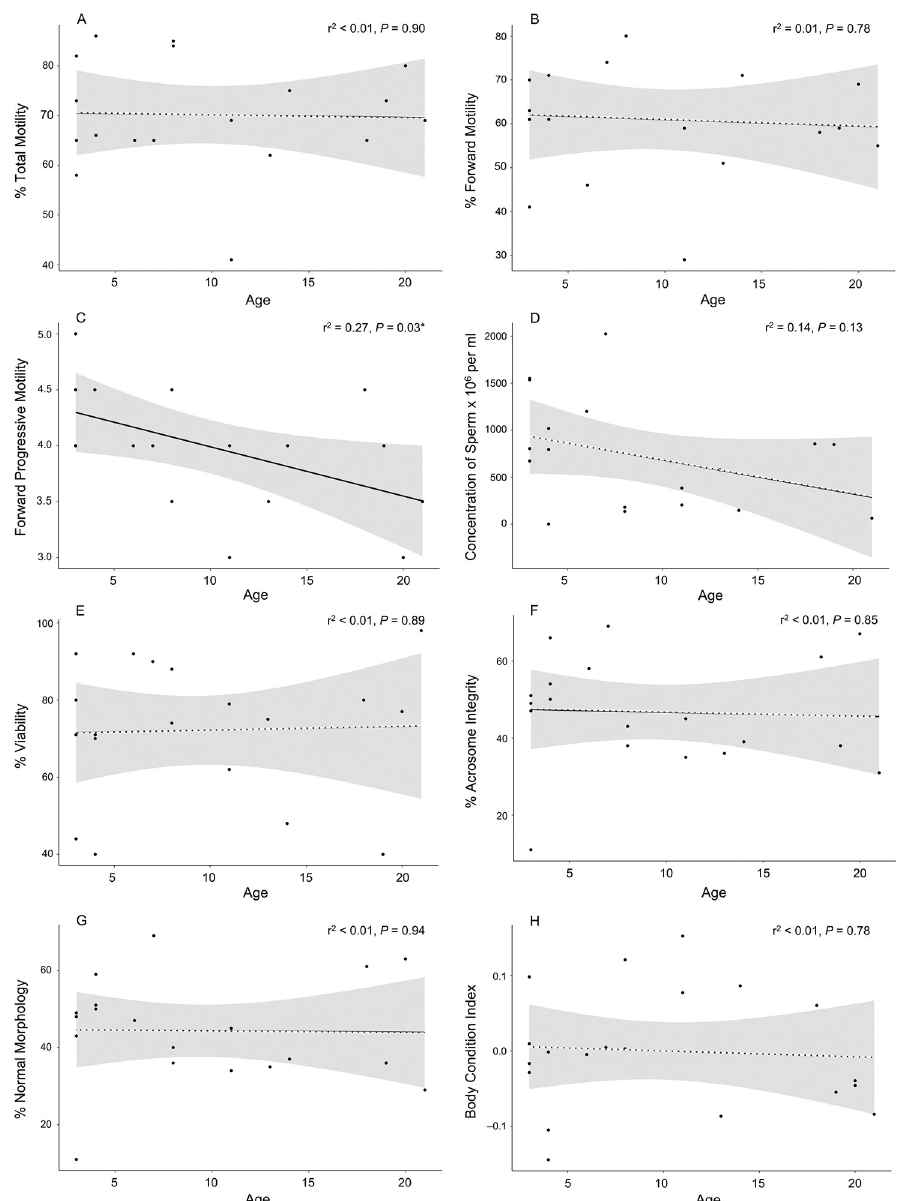
Fig 4. Scatterplots of the linear relationship between A) age and percent total motility, B) age and percent forward motility, C) age and forward progressive motility, D) age and concentration of sperm, E) age and percent viable sperm, F) age and percent normal acrosome, G) age and percent normal morphology of semen, and H) age and body condition of 20 adult male Louisiana pinesnakes. Dashed lines represent a non-significant regression line at the 0.05 level and shading shows the 95%